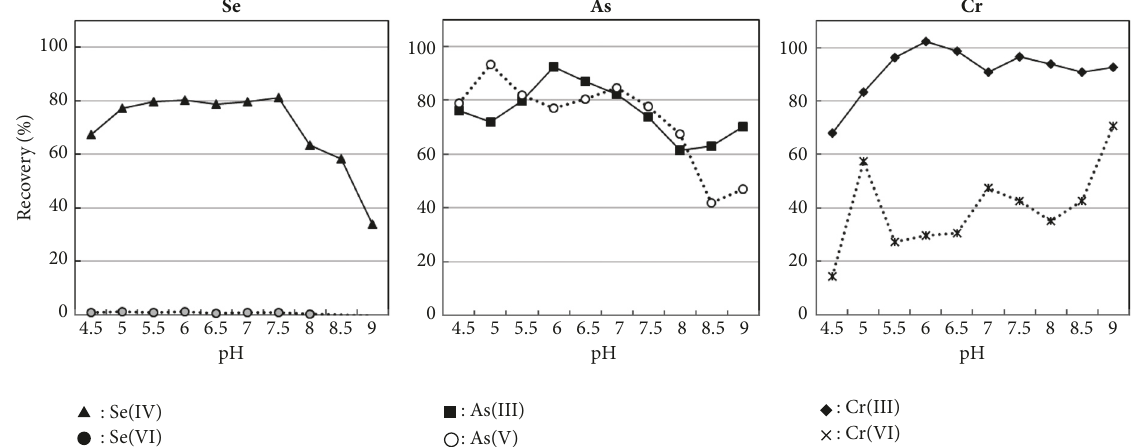
Figure 3: pH dependence on recovery of different chemical forms of Cr, As, and